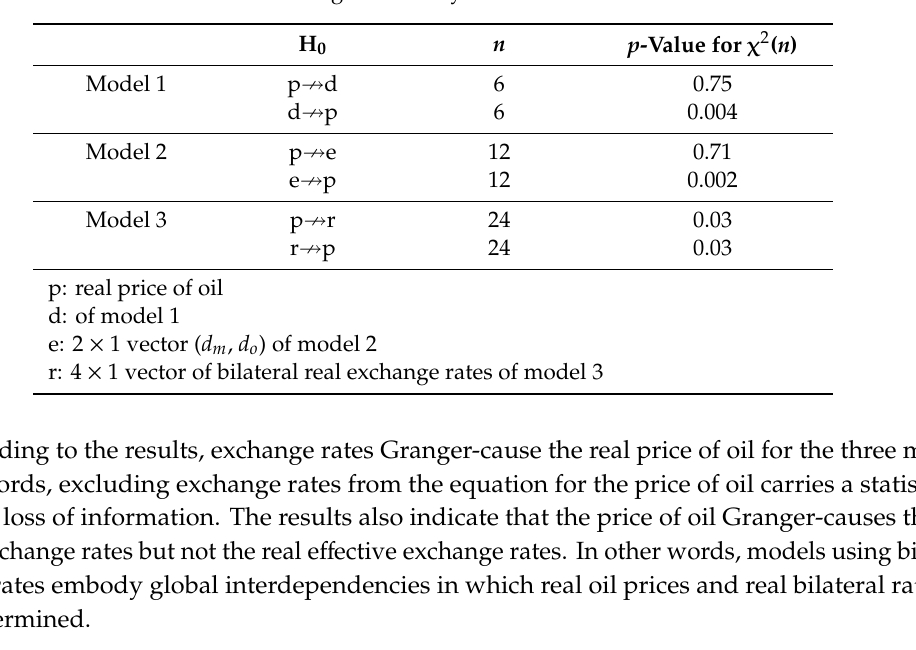
Table 2. Granger Causality Tests: